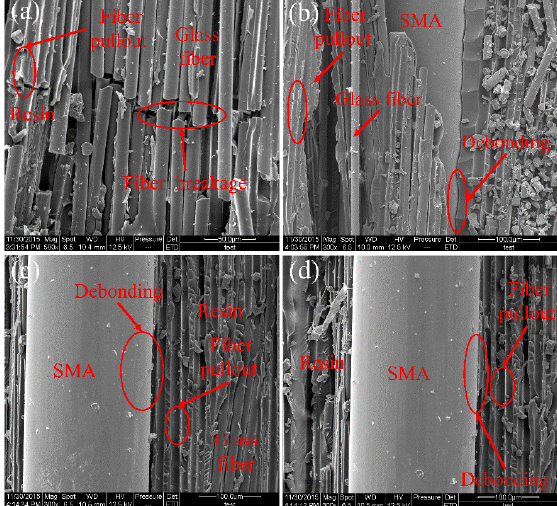
Figure 10. SEM micrograph of the fracture surface of (B-4) specimens. ( a ) B-1, ( b ) B-4-2, ( c ) B-4-4, ( d )